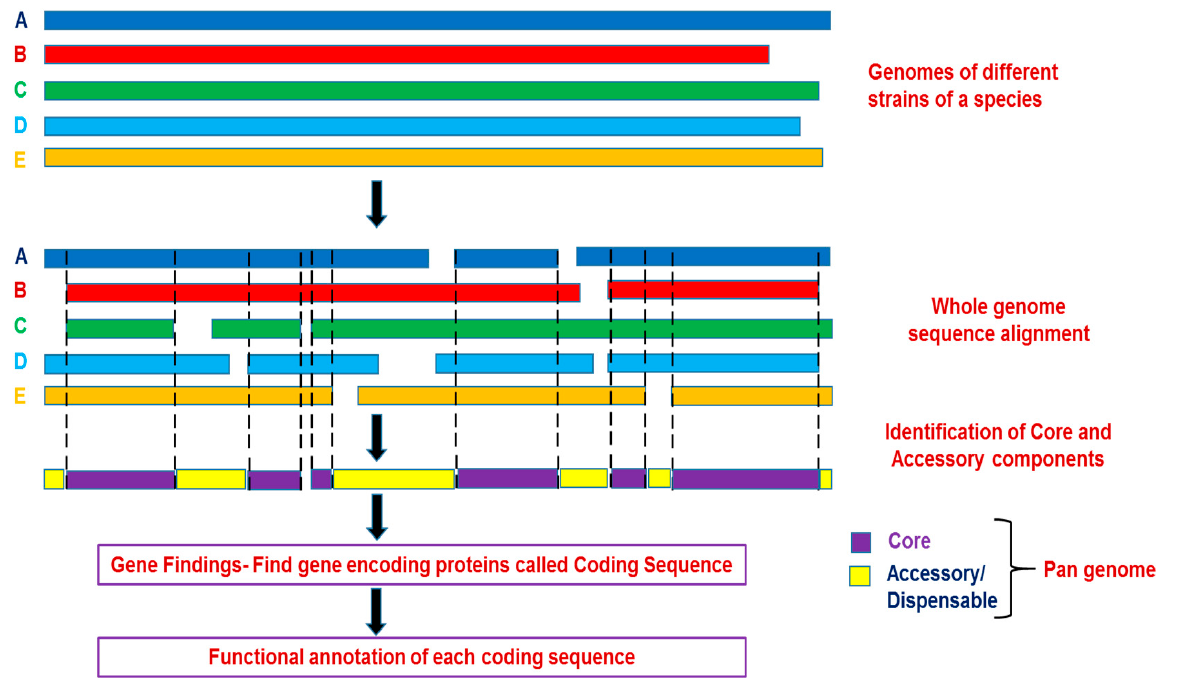
Figure 4. A basic approach for pangenome construction. Genome sequences of different strains represented schematically as A (blue), B (red), C (green), D (light blue), and E (yellow) are aligned to identify the core and accessory components of the pangenome.